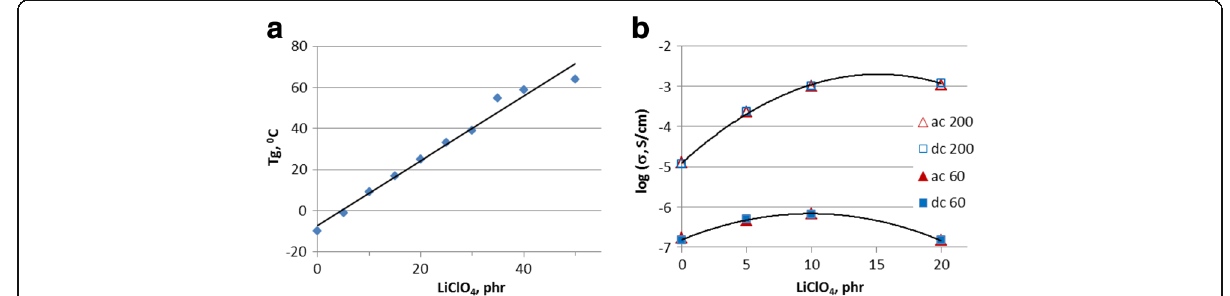
Fig. 1 Thermal and electrical characteristics of composites. a Dependence of glass transition temperature T g ( a ) and conductivity σ at 60 and 200 °C ( b ) on LiClO 4 salt